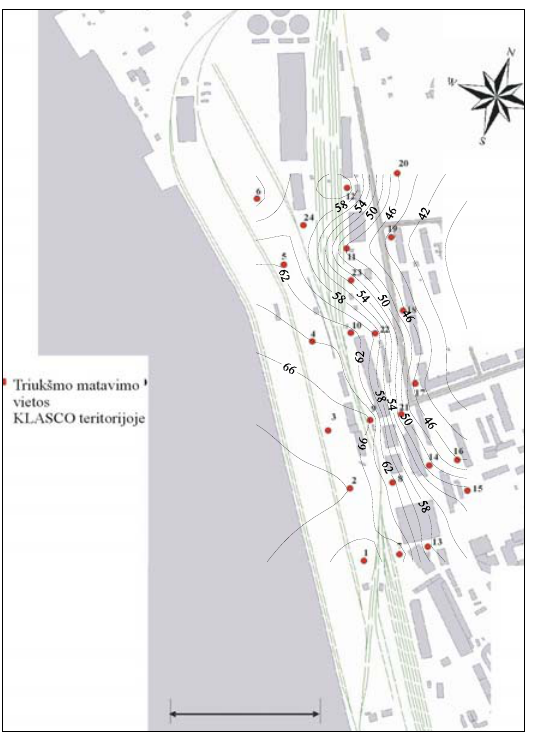
7 pav. Ekvivalentinio triukšmo lygio sklaida nakties metu rugpj ūč io m ė n. Fig 7. Dispersion of reciprocal noise level at night in Au-